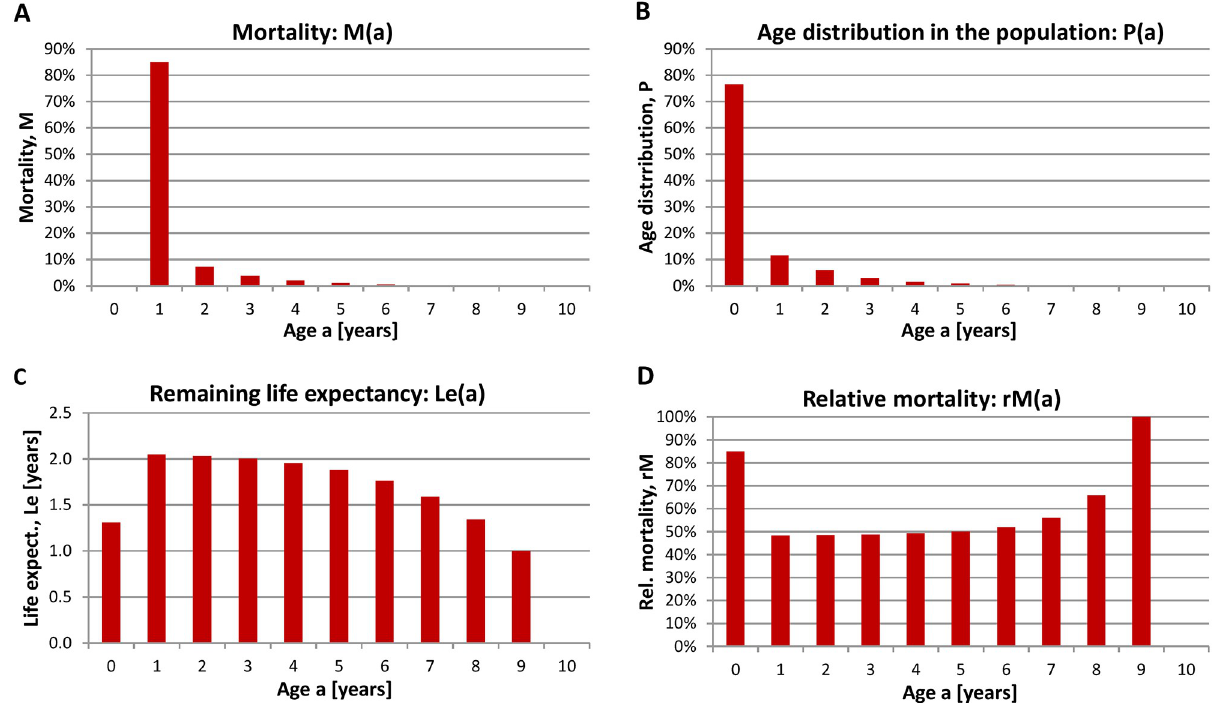
Fig 5. Population dynamics of Black Redstarts in Halberstadt (Sachsen-Anhalt, Germany) based on data including all fledglings. (A) Mortality M (a) (probability of dying at a given age), (B) age distribution in the post-breeding population (directly after fledging) P(a), (C) remaining life expectancy at a given age Le(a), and (D) relative mortality rM(a) (probability of dying when a certain age has been reached) of the Black Redstart. Calculations are based on age-differentiated bird counts taken from [15].